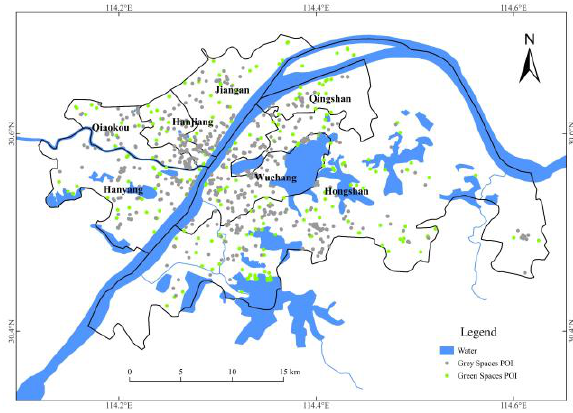
Figure 2 . Distribution of public open space in the central city of